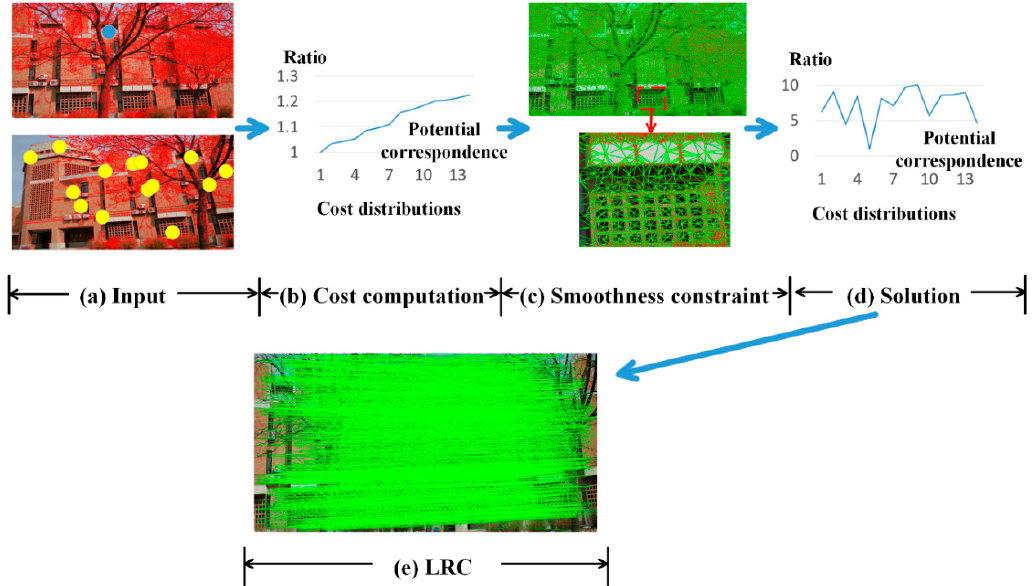
Figure 1. The workflow of the proposed method. In ( a ), red dots show the feature points in stereo pairs, the blue and the yellow circles represent a feature point in the basic image and its potential correspondences in the other, respectively. In ( b ) and ( d ), the horizontal axis represents the index of the potential correspondences, and the vertical axis represents the ratio between the matching cost at a certain correspondence index and the minimum cost of the feature point; in ( c ), the red dots are feature points, and the green edges of the triangle meshes define the spatial relationships of these feature points; in ( e ), the green lines connect matches of the proposed method after the LRC strategy.